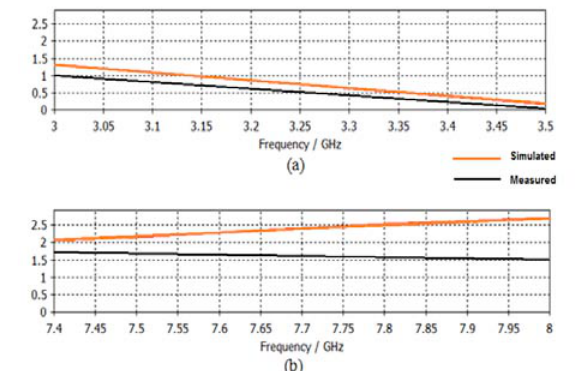
Figure 10: Measured and simulated peak gain values at (a) 3.5 GHz and (b) 7.8